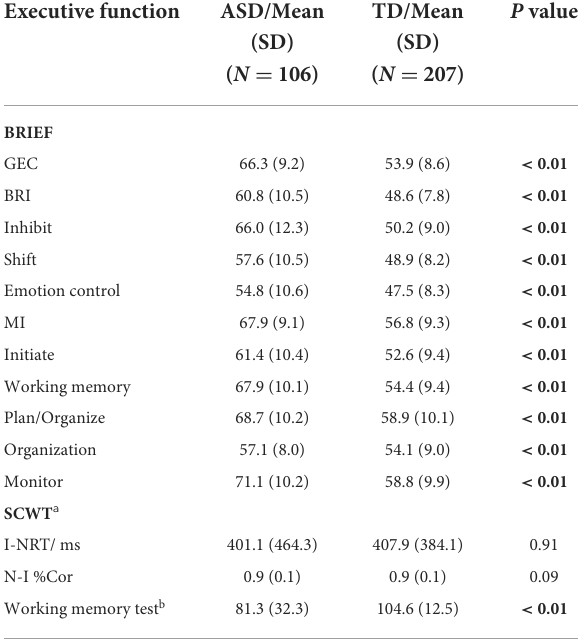
TABLE 4 The comparison of executive function in children with ASD and TD